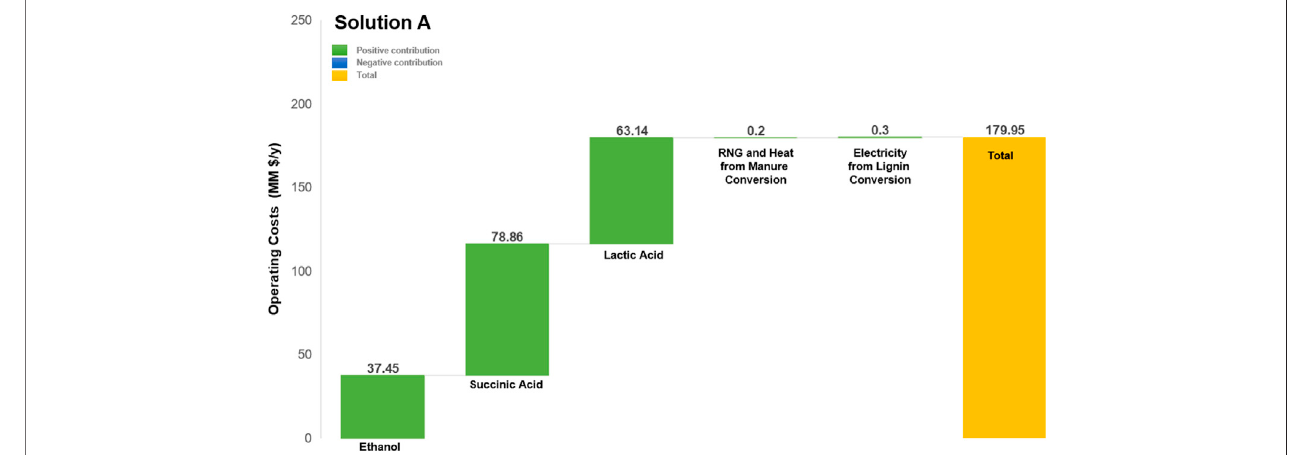
FIGURE 12 | Solution A: contribution of the main products to the operating costs.